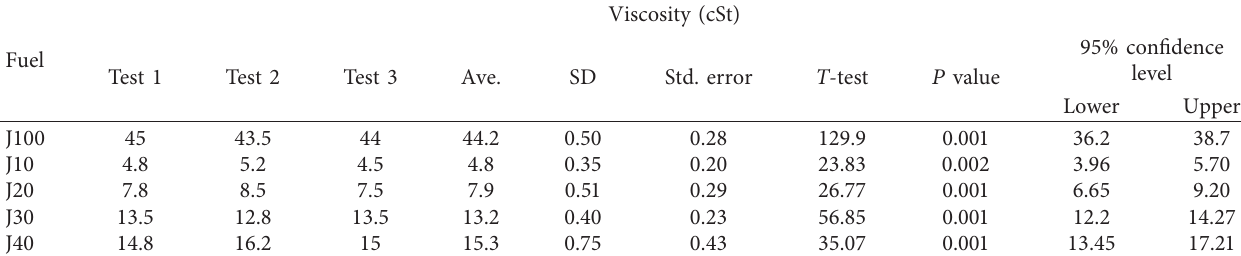
Table 3: Effect of blending on the viscosity of the Jatropha oil.